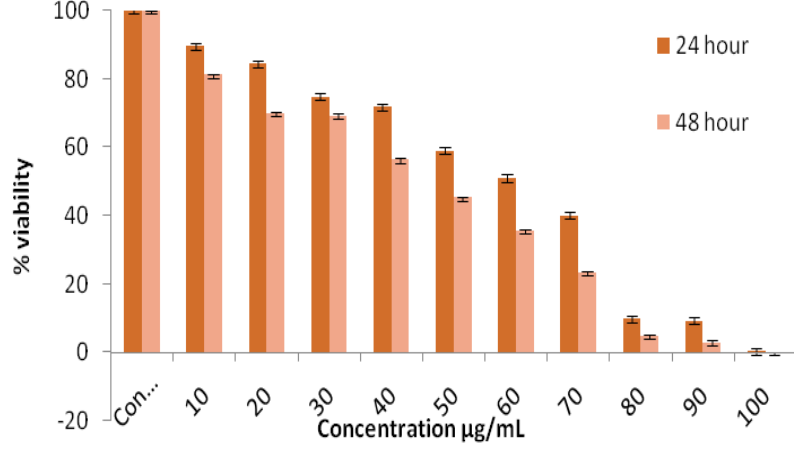
Figure 9. Cell viability assay of the PTAgNPs validated by the MTT method.